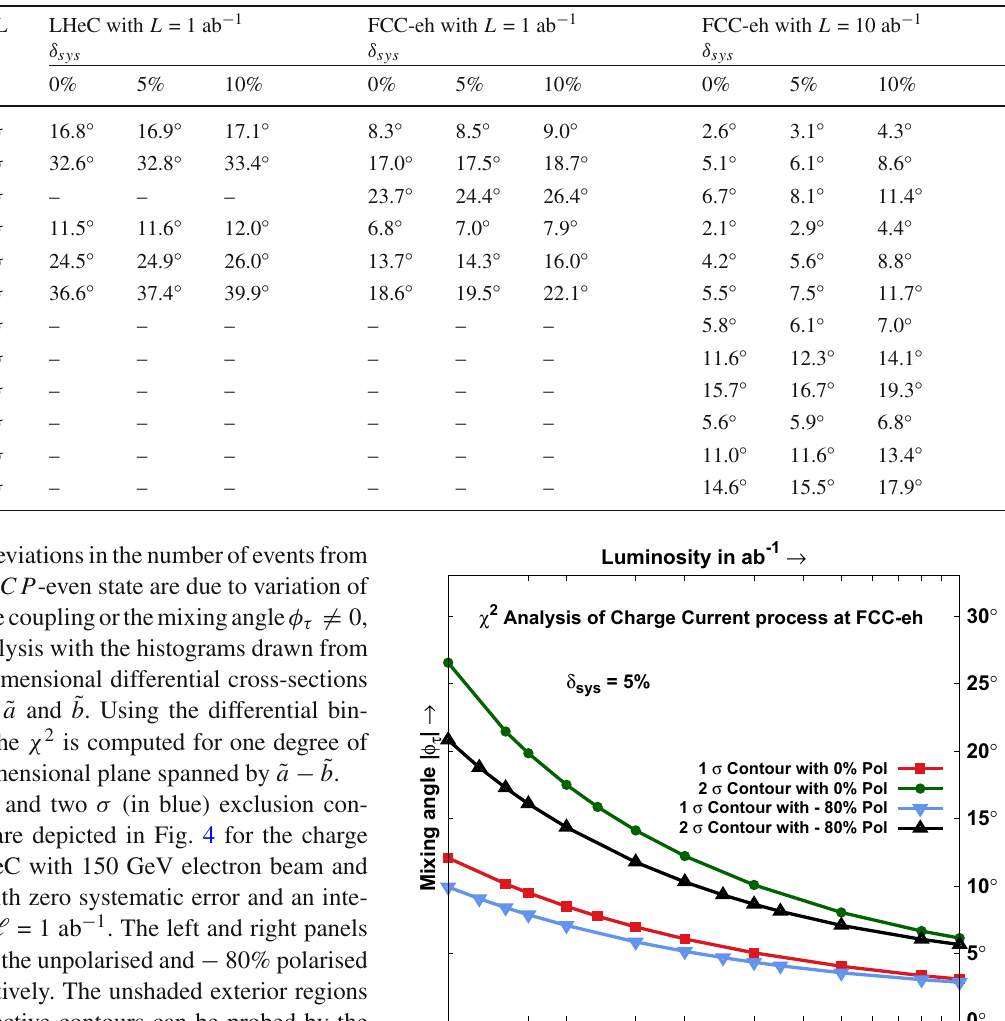
processes. The sensitivities are computed using differential bin-width ◦ corresponding to three choices of the systematic errors for (cid:14)α CP = 30 a given integrated luminosity